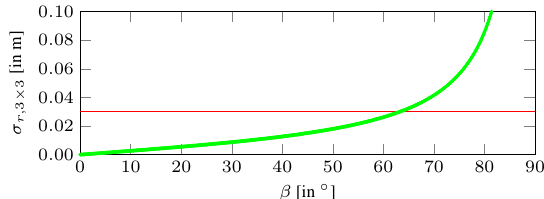
Figure 5. Behavior of the dimensionality features of linearity L λ (red), planarity P λ (green) and scattering S λ (blue) for increasing incidence angles β . Note that the synthetic data is not corrupted with noise.